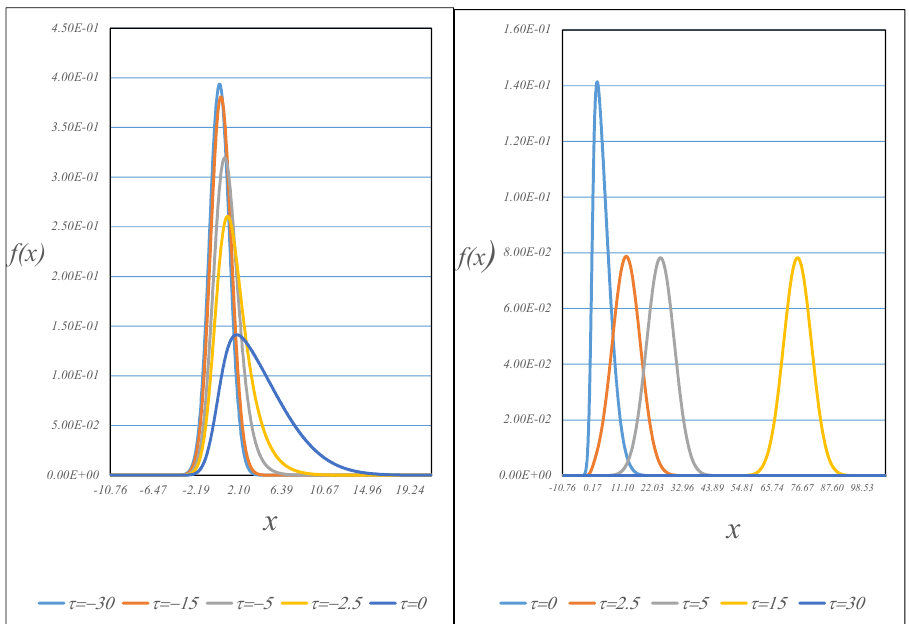
Figure 1. Extended skew-normal density functions; τ = 0, ± 2.5, ± 5.0, ± 15.0, and ±